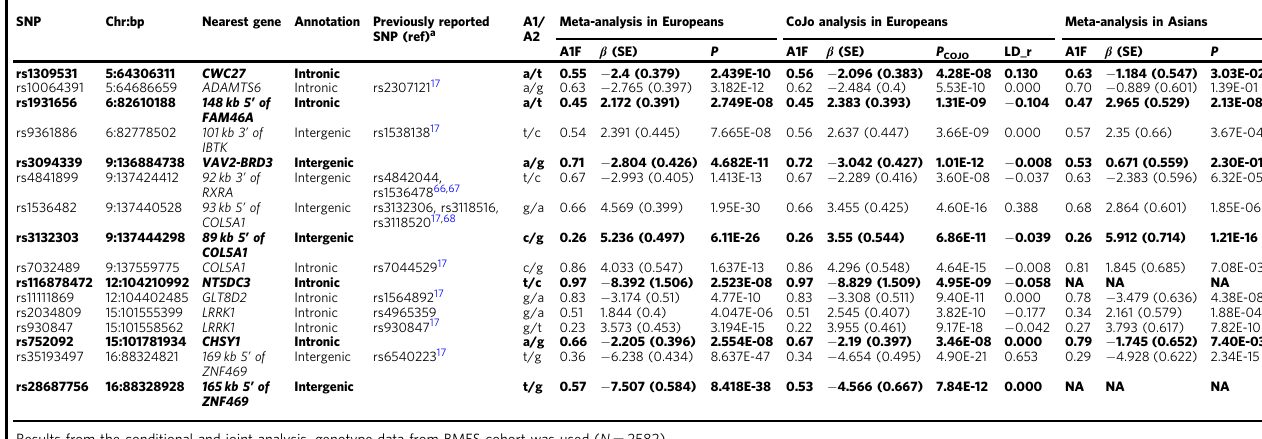
Results from the conditional and joint analysis, genotype data from BMES cohort was used ( N = 2582) Nearestgene,(referenceNCBIbuild37)isgivenaslocuslabel,butthisshouldnotbeinterpretedasprovidingsupportthatthenearestgeneisthebestcandidate,alistincludingallthegenes + / − 200kb of the lead SNP is presented in Supplementary Table 12 SNP rsID, Chr:bp chromosome: base pair, A1 risk allele, A2 other allele, A1F frequency of allele A1, β effect size on CCT based on allele A1, SE standard error of the effect size, i insertion, d deletion, r reference, P COJO = P -value after CoJo analyses a SNPs in LD ( r 2 >0.5) with SNP from CoJo analyses. In bold novel independent CCT-associated